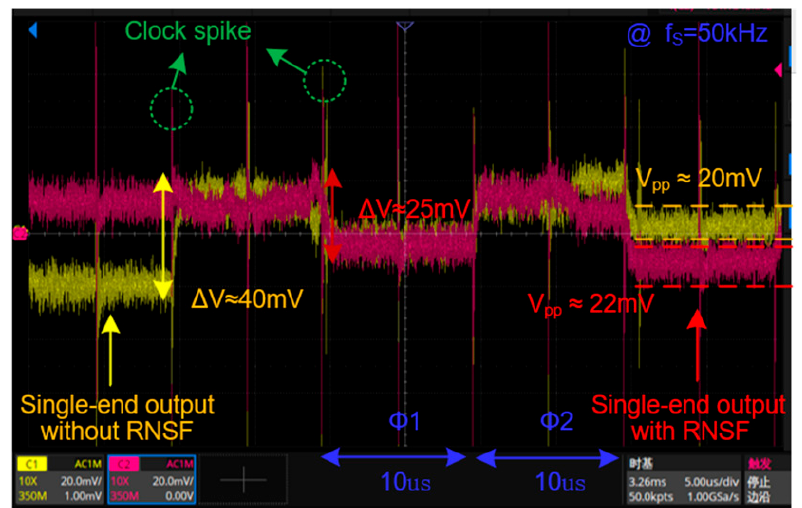
Figure 15. The test configuration of the readout IC.